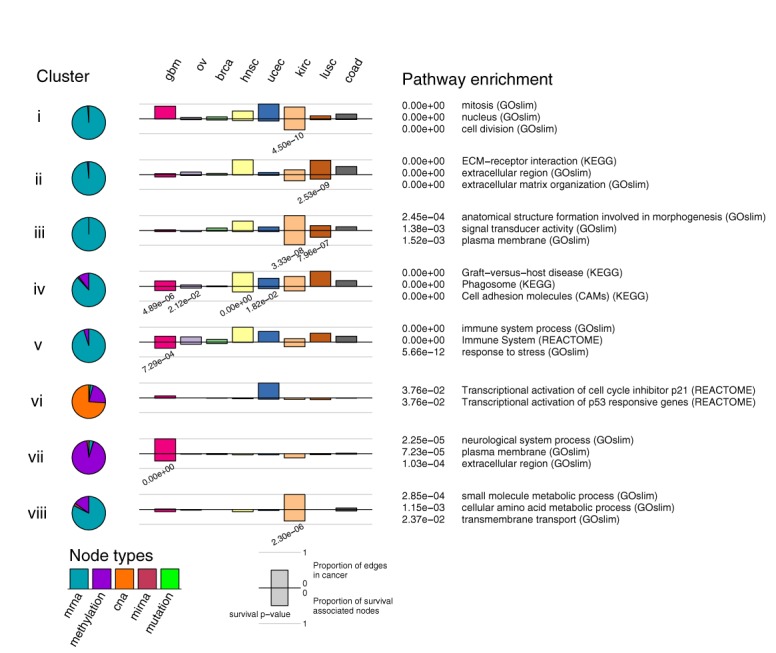
Functional annotation of network modules. Cancer Landscapes identifies and characterizes network modules across multiple cancers. Here, we display a selection of 8 clusters, organized in rows, displaying a number of properties. The pie charts (left) display the distribution of the data types of the nodes included in the cluster. The middle panel displays two properties: the bars above the middle line represent the proportion of links present in the cluster for the different cancers, and the bars below the middle line represent the proportion of significantly associated survival nodes (Materials and Methods) in each cancer. The right panel lists significantly (P– < 0.05, BH corrected) associated pathways from PathwayCommons and GOslim.